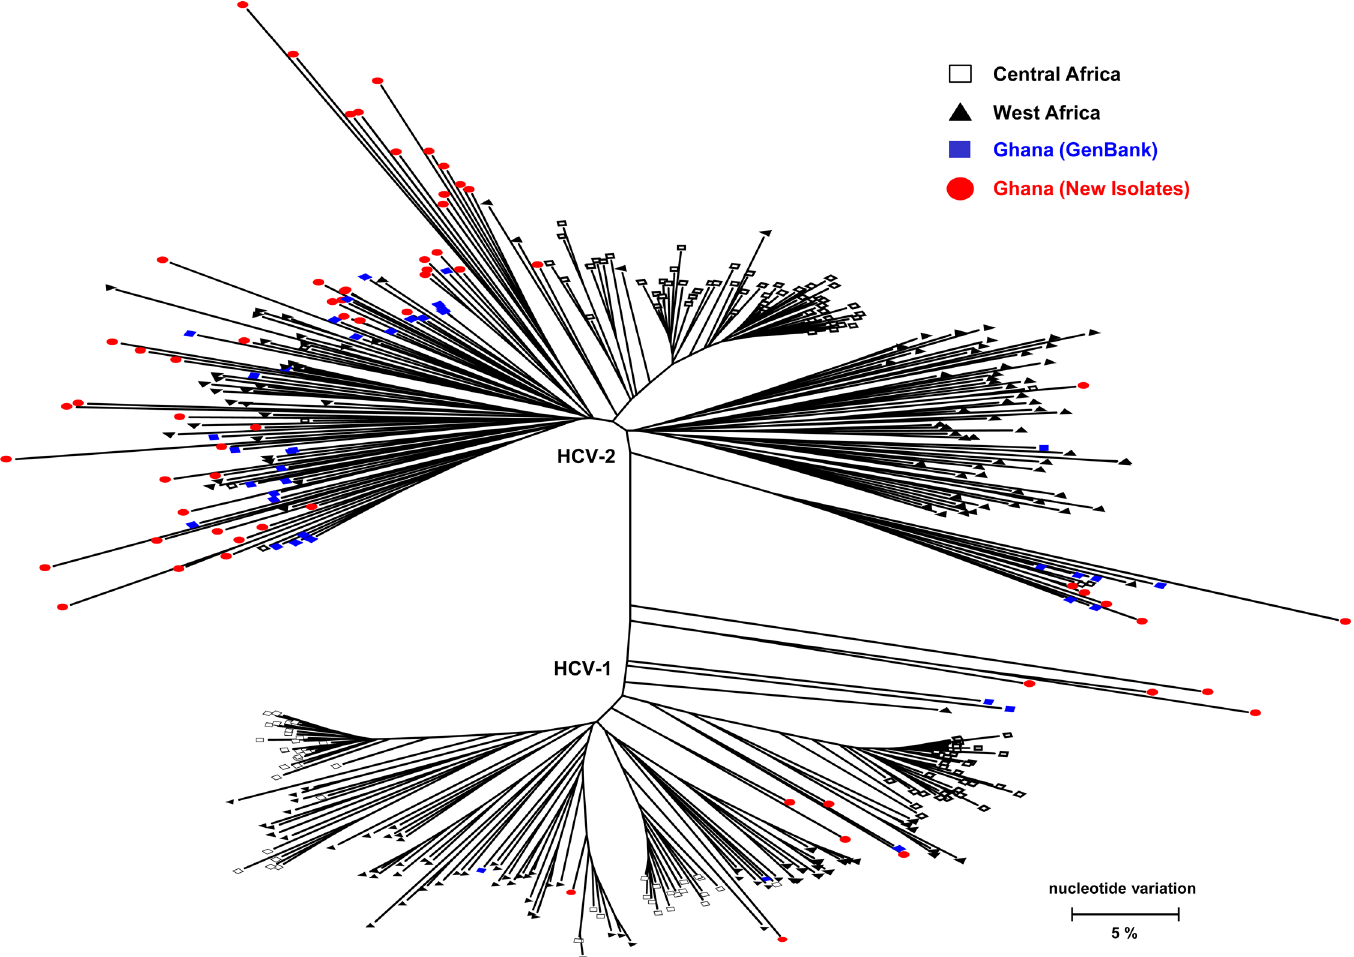
Fig 2. Maximum likelihood tree reconstructed with NS5b gene sequences from West and Central Africa. Sequences from Ghana generated in this study are shown as red filled circles, those reported from West Africa as black filled triangles and those from Central Africa as black unfilled squares. Ghanaian sequences obtained from the GenBank are shown in blue filled